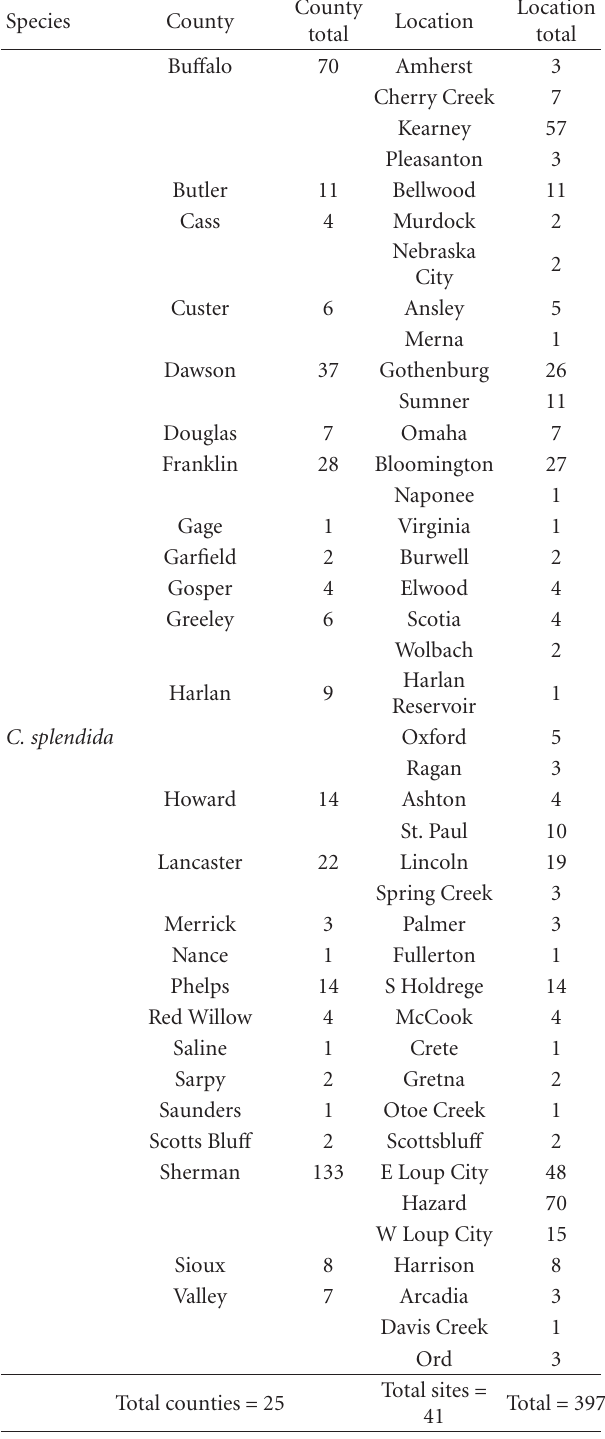
Table 4: Locality information for specimens of C. splendida ex- amined.